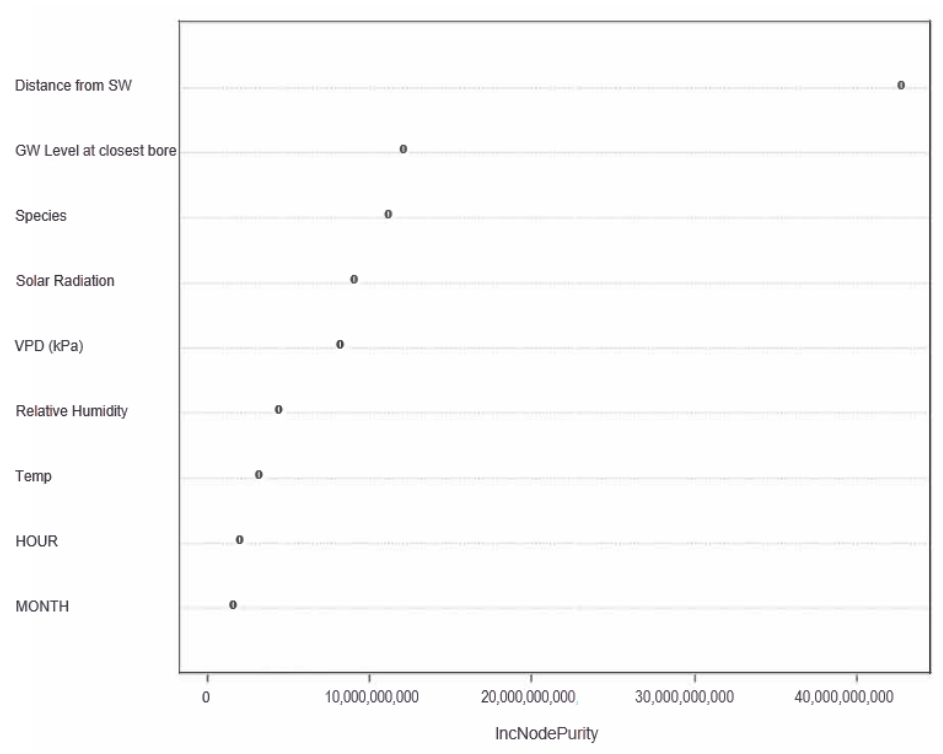
Figure 10. Random forest variable selection results for one of the five random forest models. Variables are plotted from most important in predicting sap flow (top right of panel) to least important in predicting sap flow.